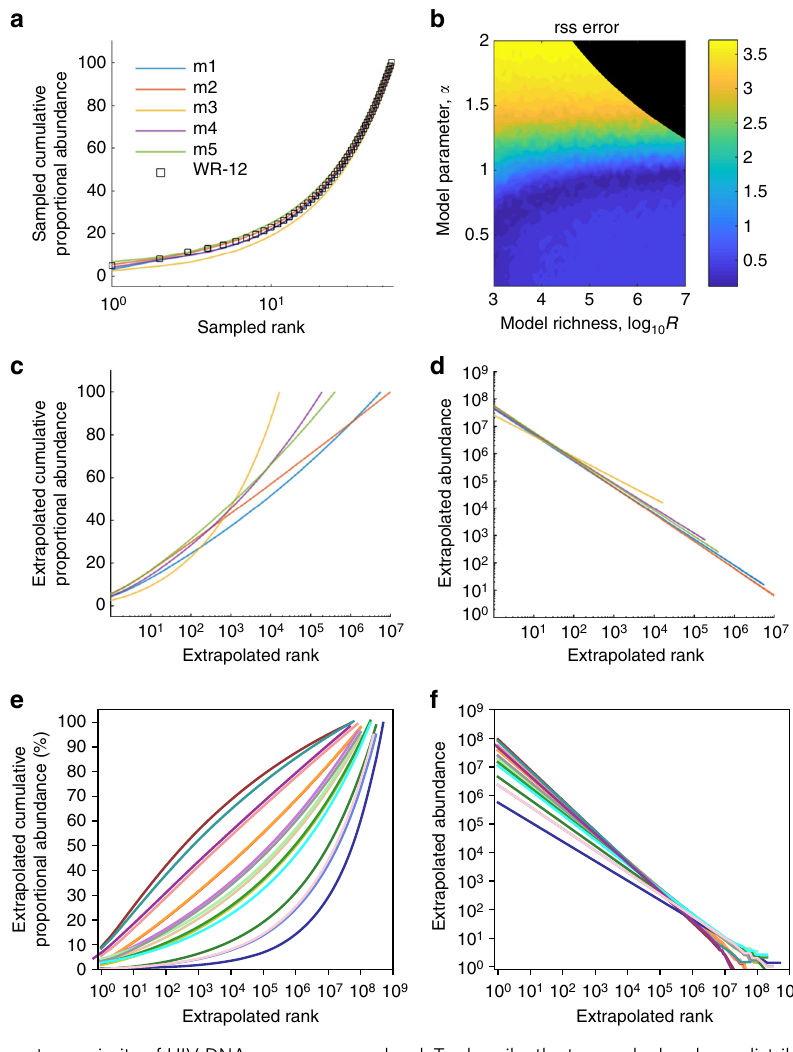
Fig. 4 Ecologic modeling suggests a majority of HIV DNA sequences are clonal. To describe the true rank-abundance distribution of the HIV reservoir, we used a power-law model and recapitulated experimental sampling (sample size equal to the experimental sample size) from 2500 theoretical power-law distributions to fi t the best model to participant data in Fig. 2a. Theoretical distributions varied according to the slope of the power-law and the true sequence richness but were fi xed at 10 9 total HIV DNA sequences. a Five best model fi ts (m1 – 5) to cumulative proportional abundance curves from a single representative participant time point (black circles: WR, 12 years on ART). b Heat map representing model fi t (dark blue optimal) according to power-law exponent α and true sequence richness R . Black shaded area represents parameter sets excluded based on mathematical constraints of the power-law (upper bound on sequence richness). A wide range of values for sequence richness allow excellent model fi t while the power-law exponent exponent is well-de fi ned. c , d Extrapolations of fi ve best models for the participant time point to a reservoir size of 10 9 cells carrying integrated HIV DNA. c Cumulative proportional abundances show that 10 4 to 10 7 clones constitute the entire reservoir. d Rank-abundance curves show the largest 1000 clones consist of >10 4 cells each. e , f Extrapolations of the maximum richness best- fi t model for each participant time point (colored to match Fig. 2a) to a total HIV DNA reservoir size of 10 9 cells. e For each participant time point, even with the maximum possible sequence richness, we note a predominance of sequence clones. 50% of the reservoir may be held in the top 200 to 20 million clones. f A small number of massive clones (top 1000 clones) each consist of >10 4 cells and a massive number of smaller clones (~10 7 ) each consist of many fewer cells relationships between log cumulative proportional abundance and log rank, respectively (Supplementary Fig. 3C, G). We esti- mated that at least 99.9% of total HIV DNA (Supplementary Fig. 3C) or replication-competent HIV (Supplementary Fig. 3G) contain true clonal sequences. The top 100 HIV DNA clones (Supplementary Fig. 3D) and replication-competent clones (Supplementary Fig. 3H) contained >10 6 and >10 4 associated cells, respectively. Using the population level data, we generated sample rarefaction curves from the extrapolated rank-abundance curves. These curves show that after 10,000 sequences were sampled, the observed sequence richness would continue to increase with more